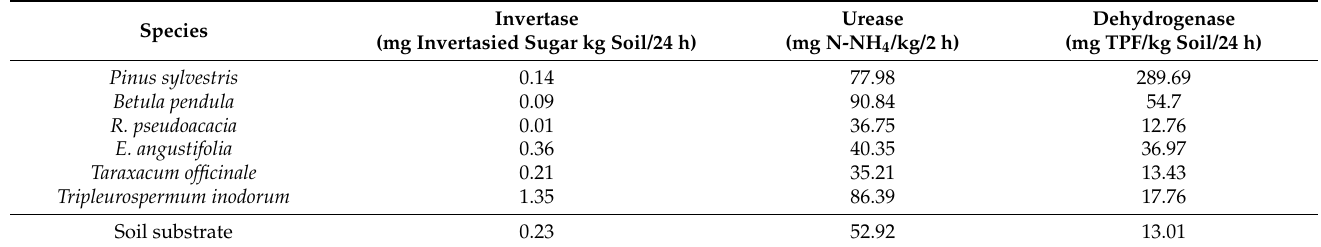
Table 3. Mean content of enzymes in plants and soil substrate.